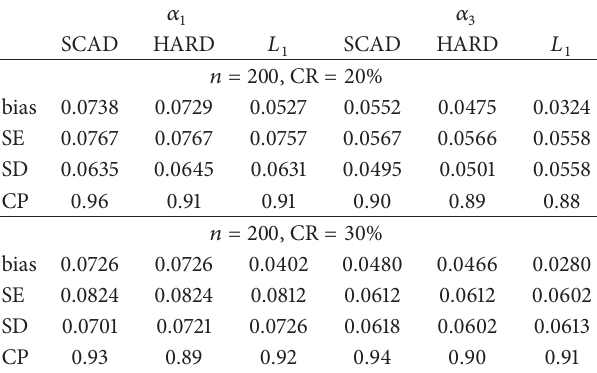
Table2:Simulationresultsforscenario(I):bias,standarderror(SE), standard deviation (SD), and coverage probability